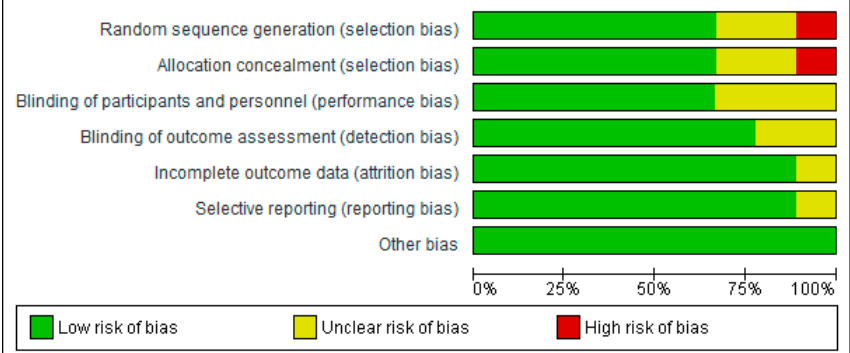
Figure 2. A summary risk of bias graph of included studies.